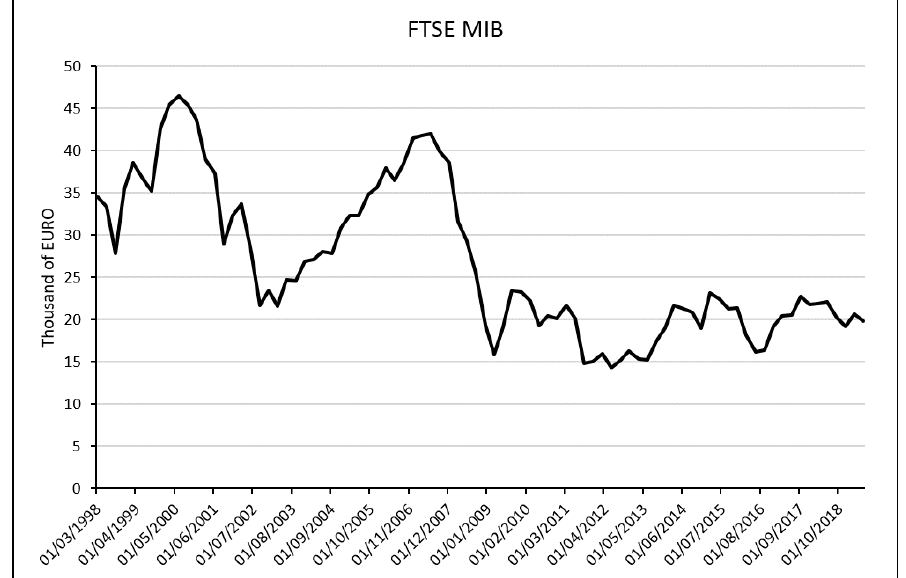
Figure 3. Closed prices of the Italian main stock index (FTSE MIB), quoted at Borsa italiana SpA (London Stock Exchange Group) from the period of 1995:Q1 to 2019:Q2 (data source: Bloomberg, 2019, ‘own